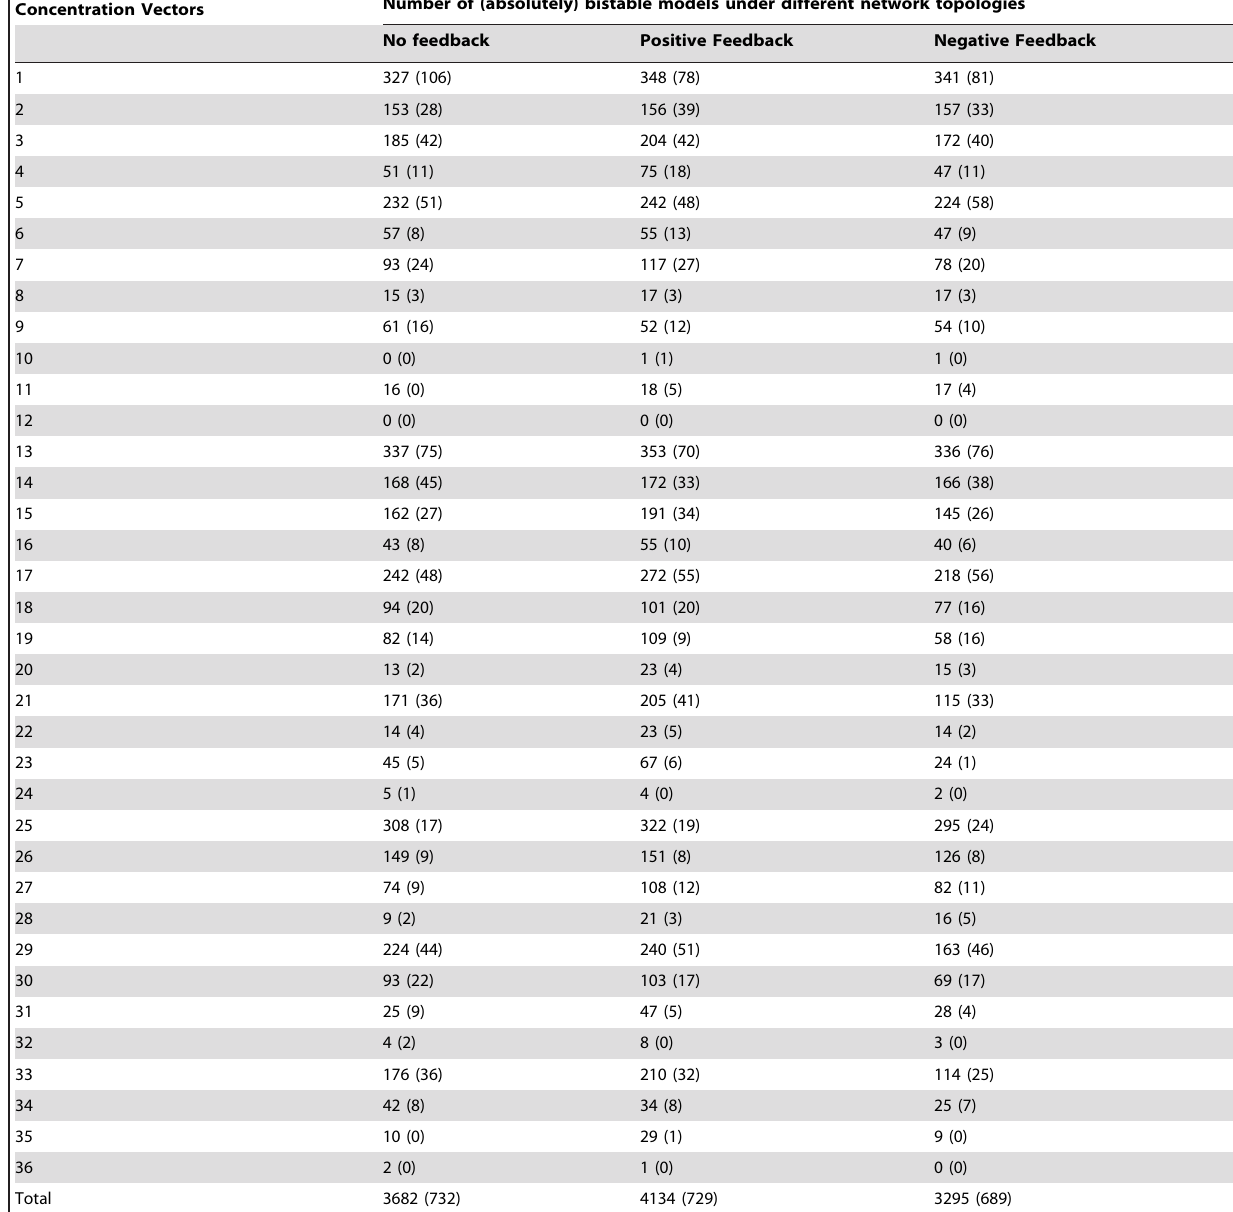
Table 3. Number of (absolutely) bistable models obtained with different concentration vectors under different network